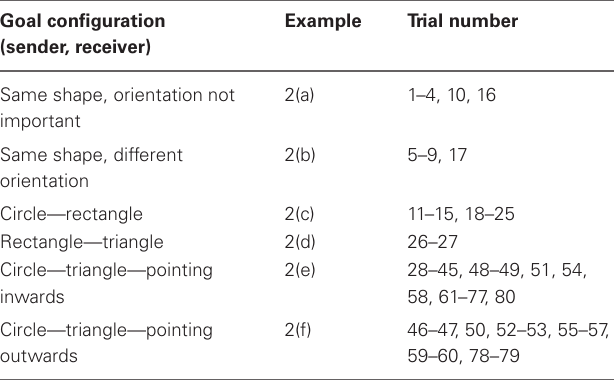
Table 1 | Overview showing the number of times that the different types of goal configurations occurred and how these were distributed over the time course of the experiment (indicated by trial